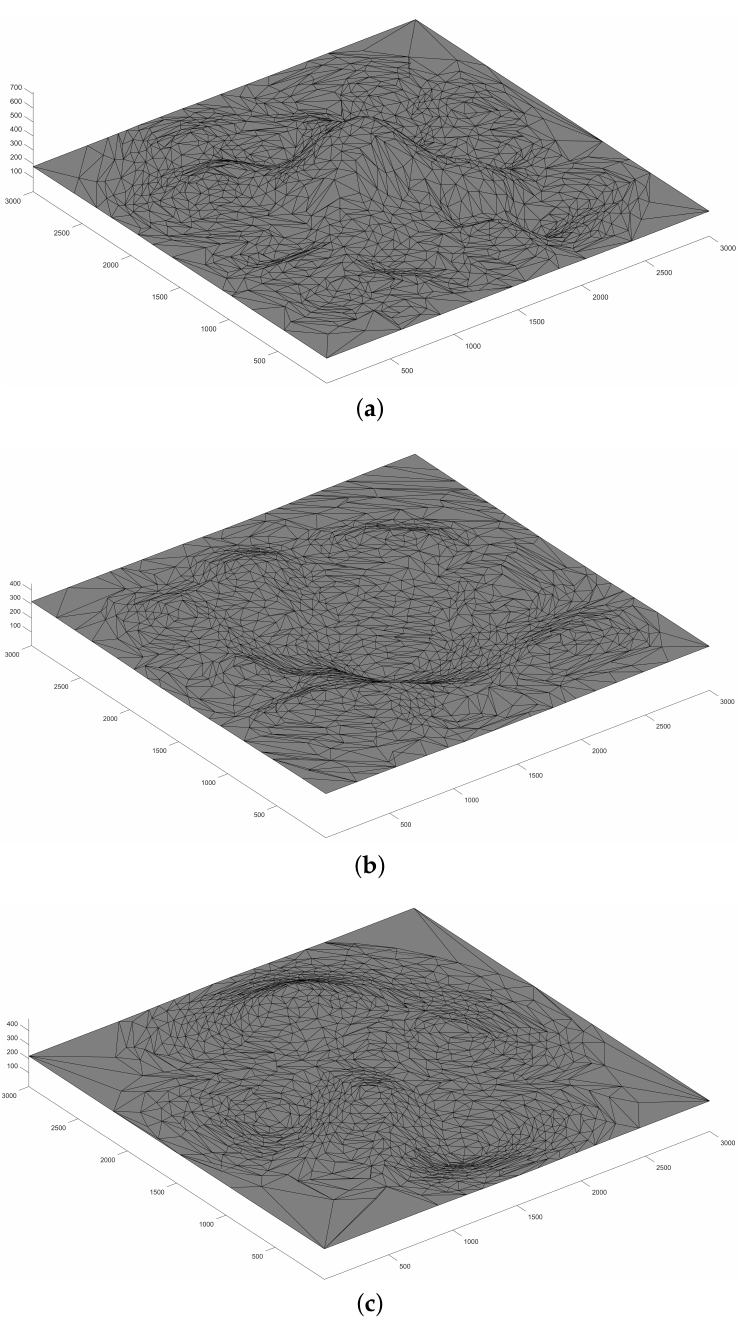
Figure 5. The terrain simplification results of: ( a ) mountain topography; ( b ) valley topography and ( c ) complex